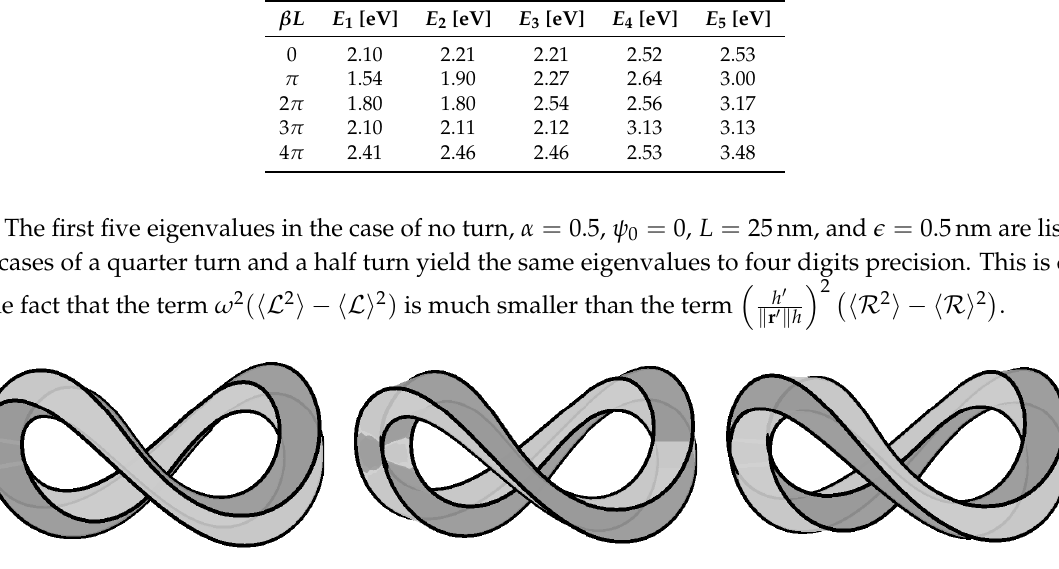
Table 1. The first five eigenvalues for the tennis ball curve with b = a /20, length 25nm, average width 1nm ( (cid:101) = 0.5nm), no turn, and trigonometric variation of width h = 1 + α